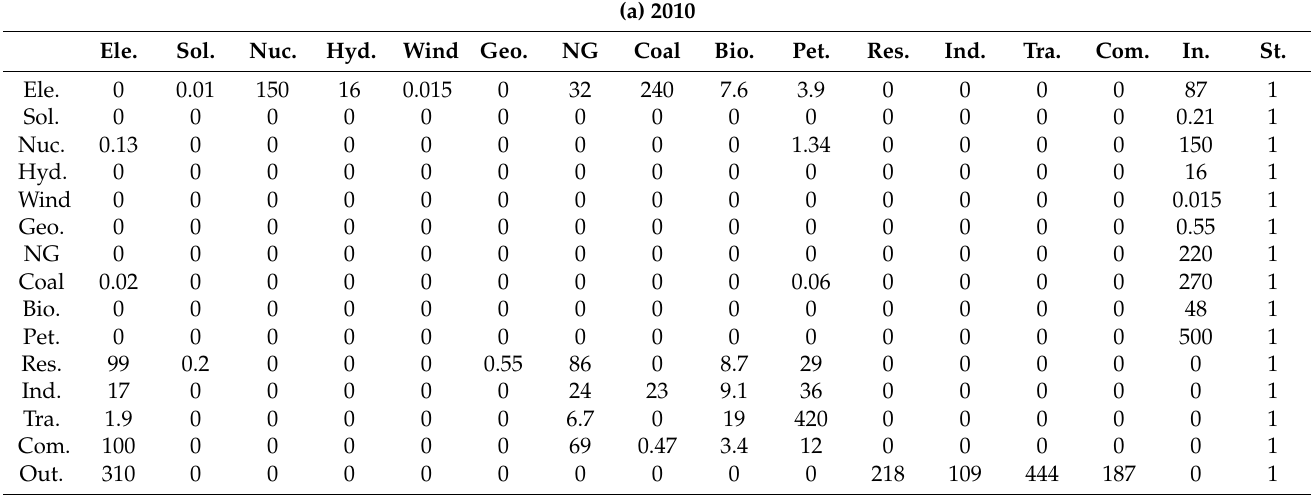
Table A1. Direct flow matrices used as ENA input. Nomenclature: ele = electricity; sol = solar; nuc = nuclear; hyd = hydro; geo = geothermal; NG = natural gas; bio = biomass; pet = petroleum; res = residential; ind = industrial; tra = transportation; com = commericial; in = input; st = storage; out = output. Nomenclature are necessary to make the flow matrices legible. The year above each flow matrix corresponds to the energy data pertinent to Maryland’s energy industry in the labeled